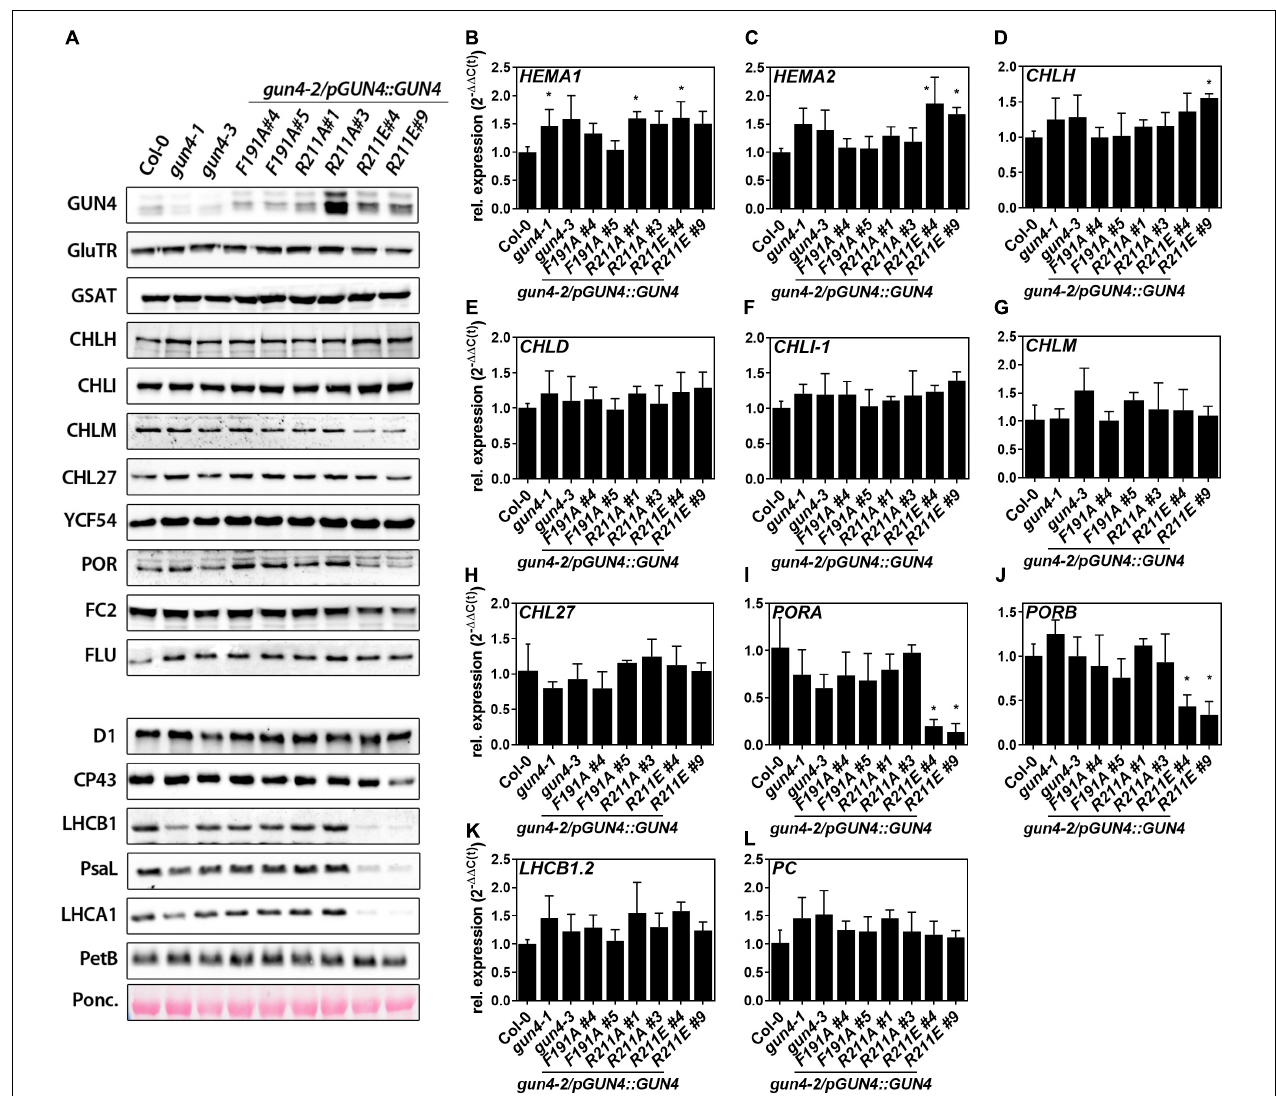
FIGURE 4 | Analysis of protein contents and gene expression in 21 day-old gun4-2 complementation lines expressing GUN4 ( F191A ), GUN4 ( R211A ), and GUN4 ( R211E ). (A) Western-blot analysis of enzymes and regulators involved in tetrapyrrole biosynthesis. (B–L) Analysis of mRNA contents by quantitative real-time PCR. Relative expression was calculated relative to Col-0 and SAND as reference gene [2 − ddC ( t ) ]. Statistical significance relative to the WT (* p < 0.05) was calculated using one-way ANOVA and Dunnett’s multiple comparison test with n ≥ 3 replicates. Values are given as the mean ± S.D. Plants were grown for 21 days in short-day (SD) conditions. GUN4, Genomes uncoupled 4; GluTR/ HEMA1 and 2, Glutamyl-tRNA reductase; GSAT, Glutamate-1-semialdehyde aminotransferase; CHLH, CHLI( -1 ), CHLD, subunits of the MgCh; CHLM, MgP methyltransferase; CHL27 and YCF54, subunits of cyclase; PORA and B,